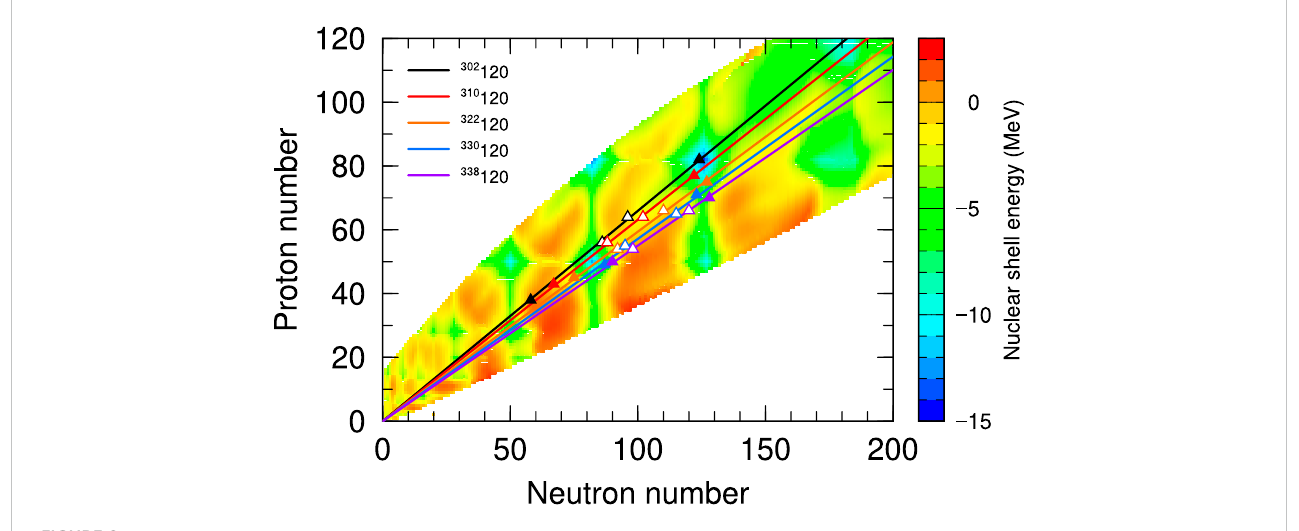
FIGURE 9 Peak positions in the nuclear fi ssion of fi ve isotopes with Z = 120 on the shell energy color map calculated by Koura et